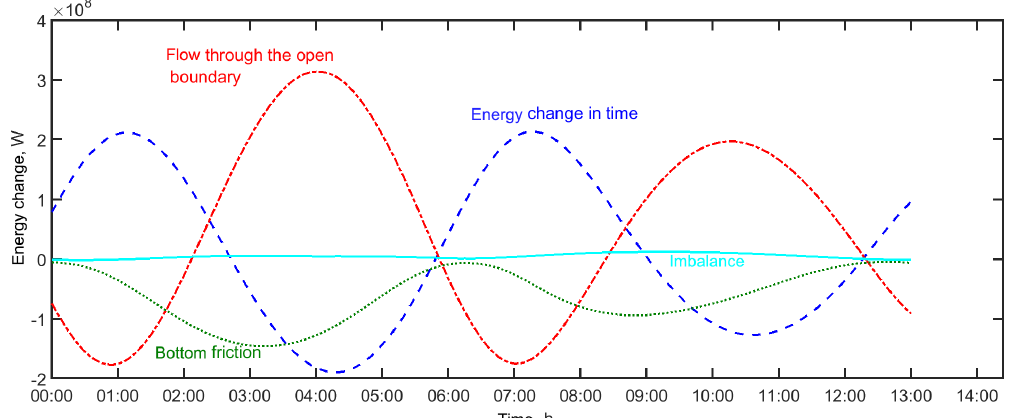
Figure 4. The energy budget for the depth-averaged solution with open-boundary conditions from the TPXO 9 database for summary tide, in watts (W): in blue (dashed line) is the energy change in time, in red (dash-dotted line) is the flow through the open boundaries, in green (dotted line) is the bottom friction and in cyan (solid line) is the imbalance.